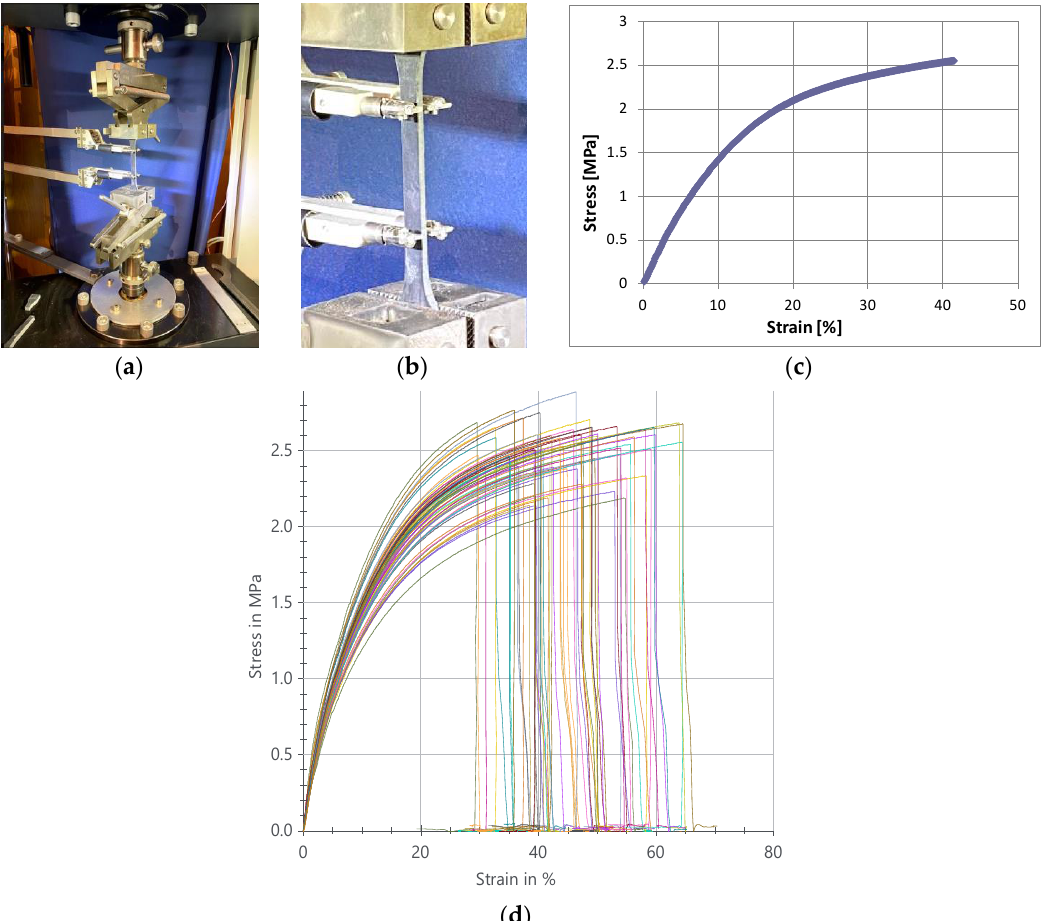
Figure 3. A sample prepared for the tensile test: ( a ) setup from a testing machine, ( b ) PS-polyurethane dog-bone specimen with long-travel extensometer, ( c ) non-linear stress-strain characteristic of a reference (I) specimen in the tensile test, ( d ) stress-strain characteristics range of all specimens (I-X) tested in tensile.